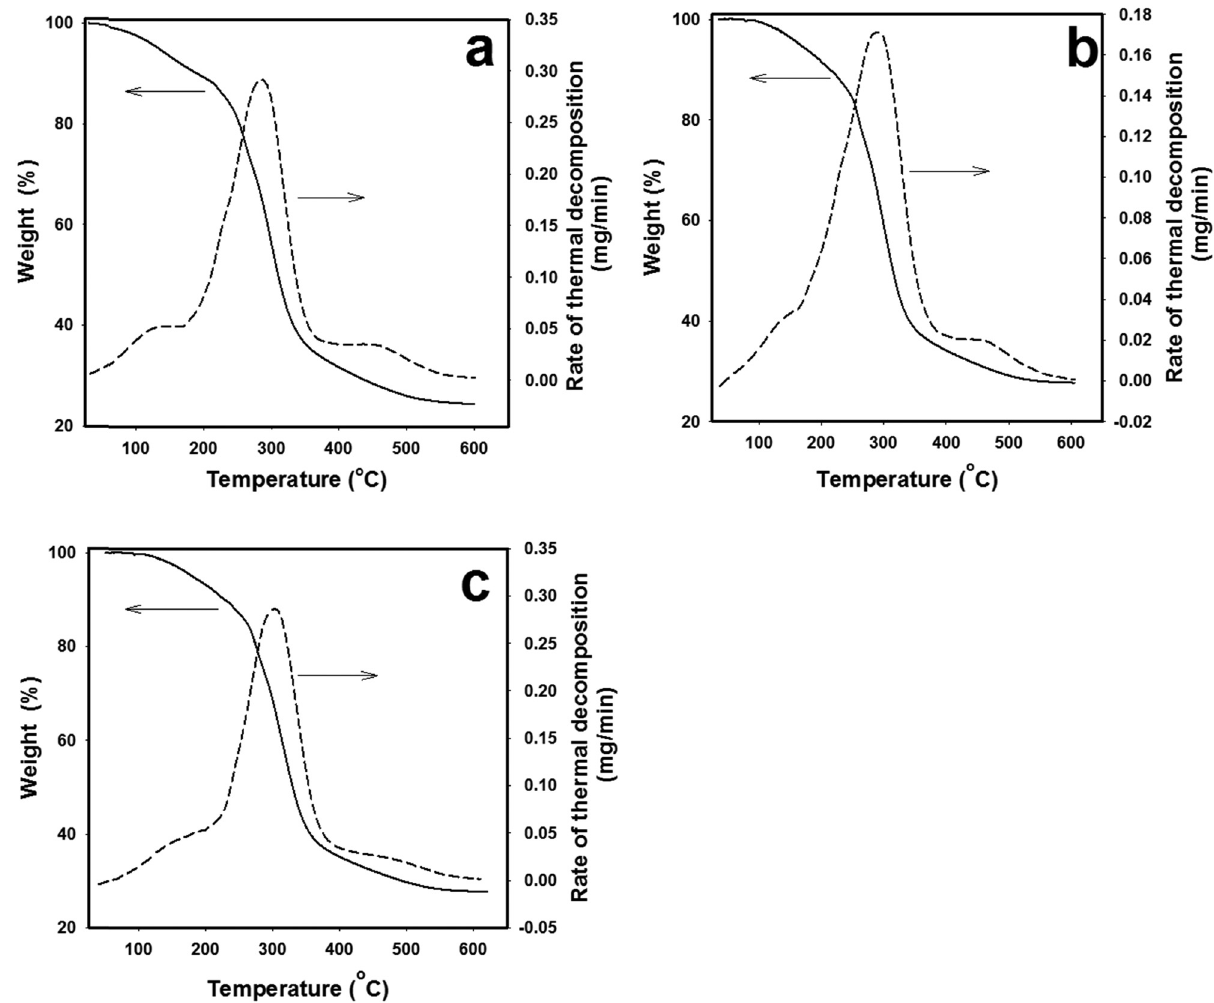
Figure 8: TGA curves of ( a ) PVP/CMC fi lm ( 2/1 ) , ( b ) ( PVP:CMC ) /ZnO nano fi lm irradiated at 5 kGy, and ( c ) ( PVP:CMC ) /ZnO nano fi lm irradiated at 20 kGy PVP:CMC with a particular PVP:CMC ratio ( 2/1 ) and ZnO content ( 1.2 wt% )